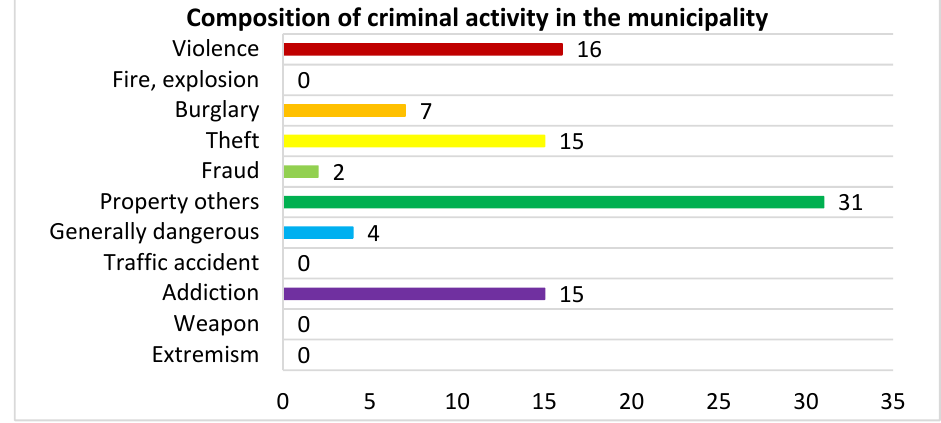
Figure 3. composition of criminal activity within a specific municipality of CZ [adopted from